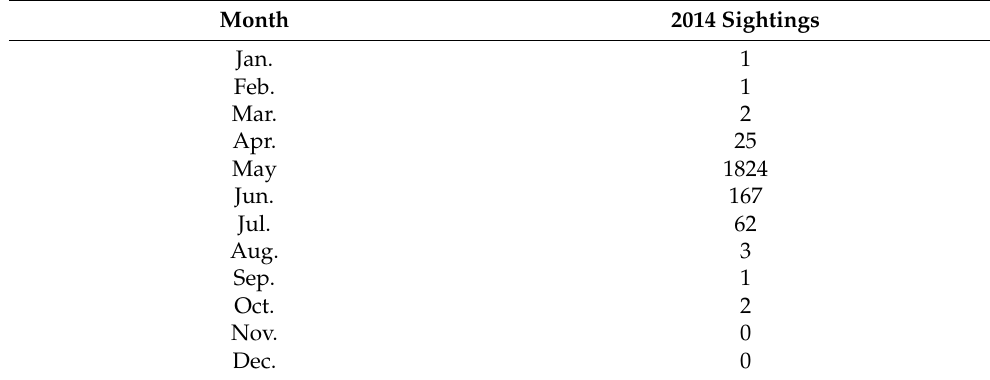
Table 2. The total number of sightings of L. zampa classified by months in 2014.